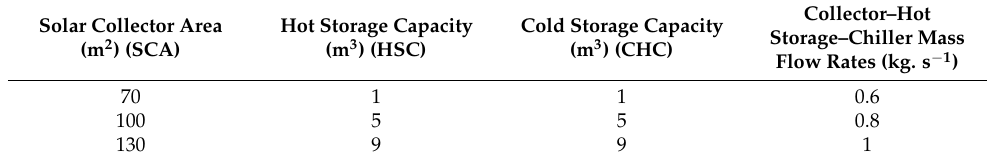
Figure 8. principal components of the solar-thermal-cooling system. Figure 8. Principal components of the solar-thermal-cooling system. Table 1. Initial parametric analysis layout. Table 1. Initial parametric analysis